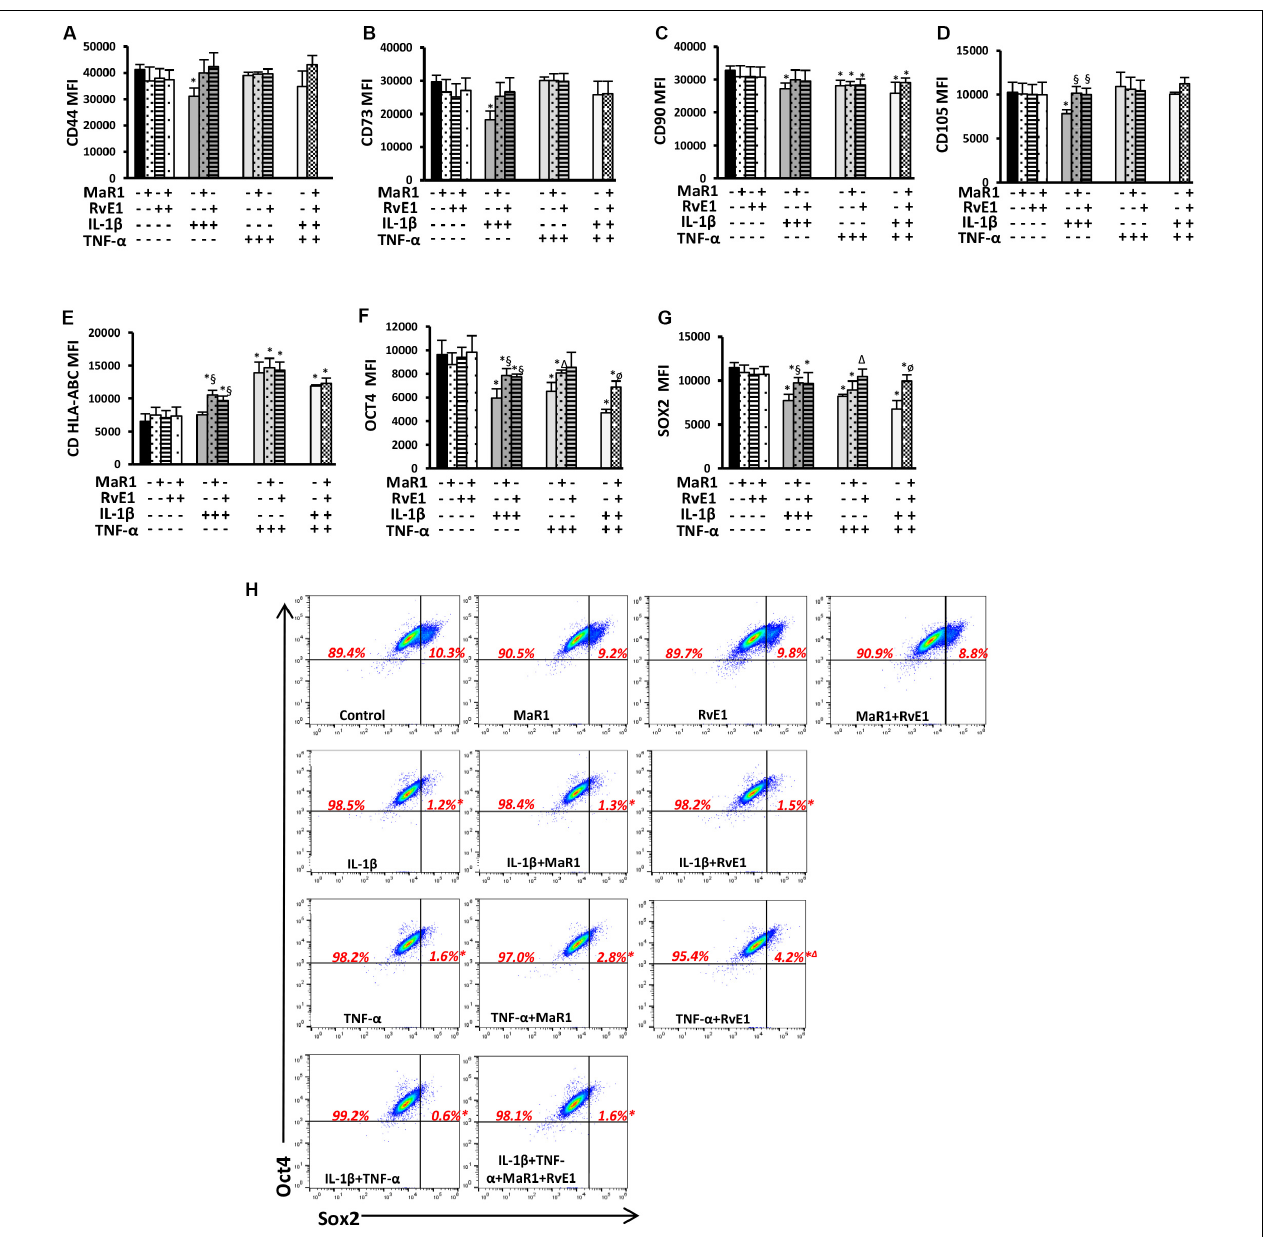
FIGURE 1 | (A–G) Mean fluorescence intensity (MFI) analysis of positive surface and pluripotency markers (A–G) . (H) Representative dot plots displaying percentages of Sox2 + and Oct4 + hPDLSCs. (*) p < 0.05 vs control (non-stimulated); (§) p < 0.05 vs IL-1 β treated group; ( (cid:49) ) p < 0.05 vs TNF- α treated group; ( ø ) p < 0.05 vs IL-1 β +TNF- α treated group. ANOVA with post-hoc test Tukey was used to determine statistical differences between experimental groups at the 0.05 level. Results are given as mean ± SEM of three independent